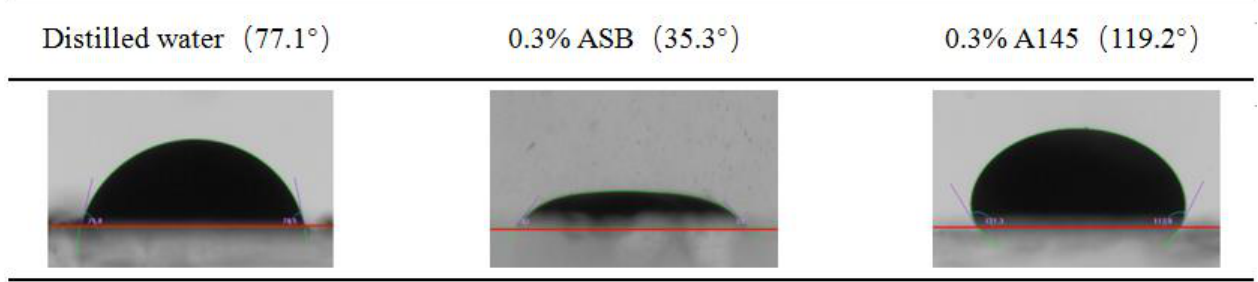
Figure 4. Macro-static crude oil/water/solid three-phase contact angles.